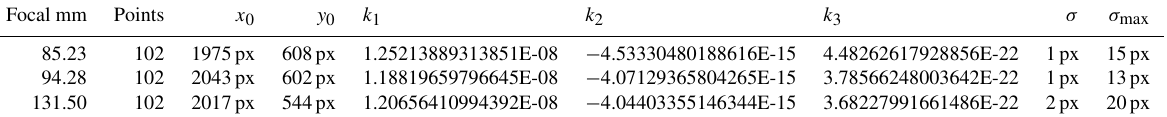
Table 1. Coefficients of radial distortion and position for PPS. The two last columns show the RMS error and the maximum error for radial distortion respectively. We considered 102 points for the polynomial adjustment. The first column shows the values for the calibrated focal lengths (mm).